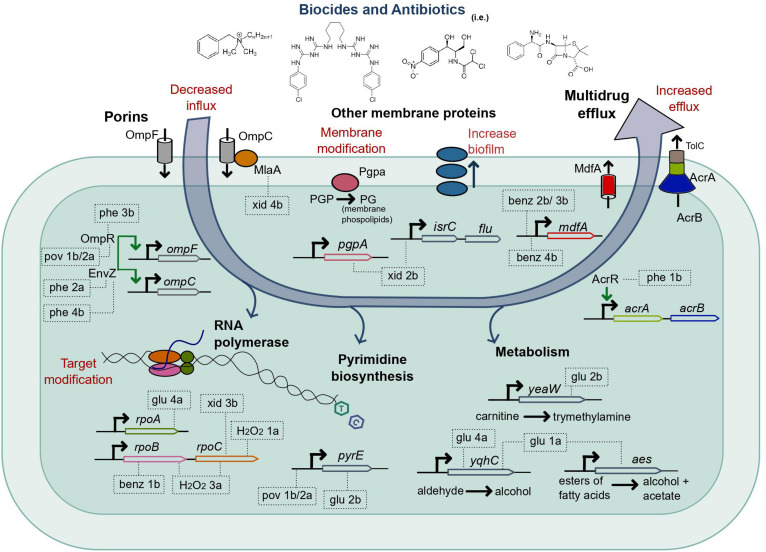
Mutations selected by the adaptive laboratory evolution of E. coli in biocides in strains cross-resistant to antibiotics. The systems and processes of the E. coli cell, which exhibited mutations after ALE in biocides, are shown in bold. The evolved strains cross-resistant to at least one antibiotic are represented inside dashed rectangles, which point to the gene or gene region with a detected mutation; for a complete list of mutations, see Table 2. The strains glu 2b, glu 1a, and xid 2b had only mutations not previously associated to antibiotic resistance (there is no precise mechanism reported in the literature), and the gene functions in the cell (Kanaya et al., 1998; Turnbough and Switzer, 2008; Lu et al., 2011; Koeth et al., 2014; Wang et al., 2015; Laganenka et al., 2016) are indicated for reference. Xid, chlorhexidine; pov, povidone-iodine; phe, chlorophene; benz, benzalkonium chloride; glu, glutaraldehyde.